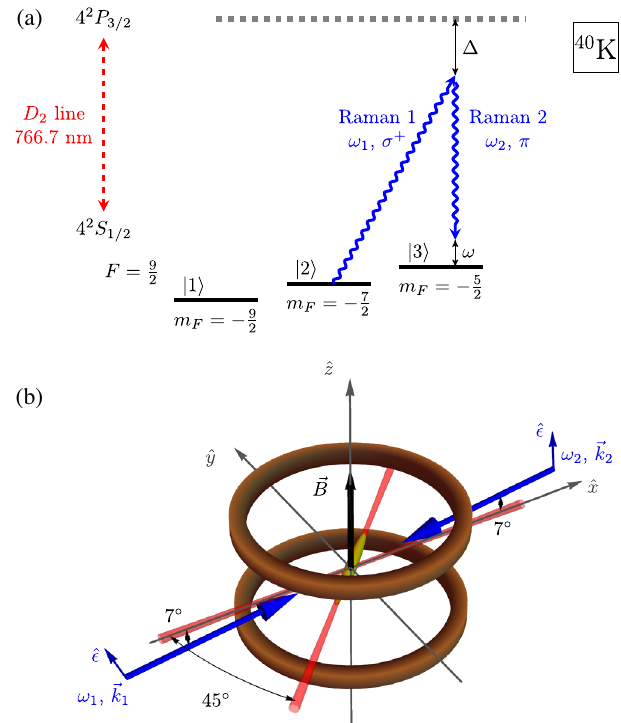
FIG. 1. Experimental setup. (a) Level diagram of the relevant states in 40 K. The majority of atoms occupy state j 1 i ¼ j F ¼ 9 = 2 ; m F ¼ − 9 = 2 i in the 4 2 S 1 = 2 manifold, and their inter- action with the minority atoms in state j 2 i ¼ j F ¼ 9 = 2 ; m − 7 = 2 i can be tuned in the vicinity of the Feshbach F ¼ resonance at B ≈ 202 . 14 G [56]. The counterpropagating Raman beams (wiggly blue lines) are pulsed for 500 μ s and couple atoms in state j 2 i to state j 3 i ¼ j F ¼ 9 = 2 ; m F ¼ − 5 = 2 i , which is initially unoccupied. Afterward, we detect the number of atoms in state j 3 i [56]. The single-photon Raman detuning is Δ ¼ − 2 π × 54 . 78 ð 8 Þ GHz relative to the D 2 transition. (b) 3D sketch of the beam configuration in the experiment. Two Raman beams with orthogonal polarization (blue lines with arrowheads) overlap the atomic cloud (yellow), which is being held in an elongated crossed-beams optical dipole trap (red lines). The optical 2 π × 238 ð 3 Þ Hz and trap oscillation frequencies are ω radial ¼ ω 2 π × 27 ð 2 Þ Hz, in the radial and axial directions, re- axial ¼ spectively. The gravitational acceleration direction is − ˆ z